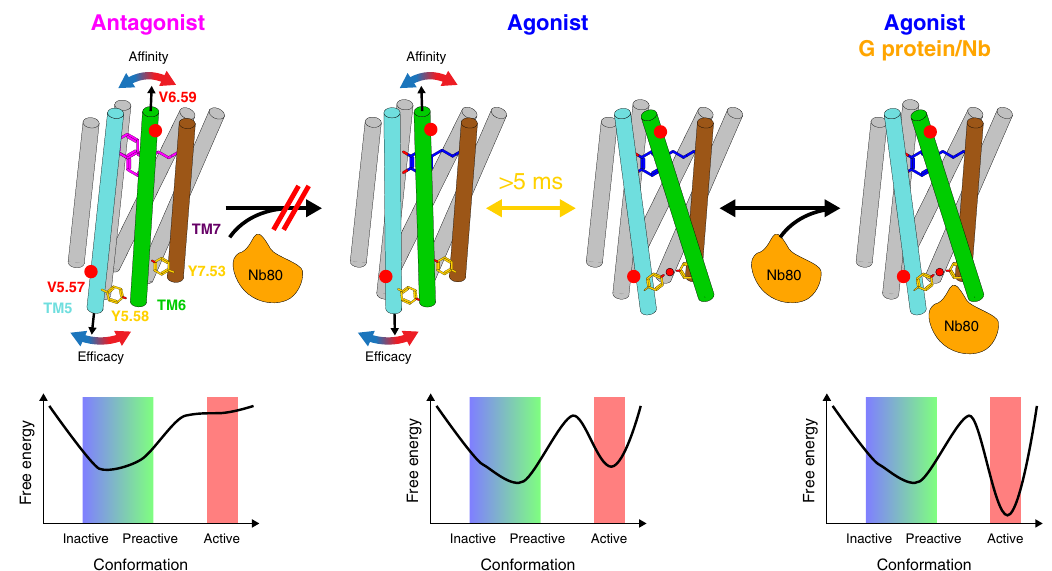
Fig. 8 Overview of observed β 1 AR conformational dynamics in response to ligands. Top: overview of conformational averages in various ligand-bound forms: (i) the antagonist complex in fast equilibrium biased to an inactive conformation, (ii) the agonist complex in fast equilibrium biased towards the preactive conformation and in a further slow equilibrium (closing of YY-bridge) with the active conformation, (iii) the ternary agonist (cid:129) effector protein complex in the fully active conformation. Arrows indicate readouts of conformational averages provided by chemical shifts that correlate to ligand ef fi cacy (V 5.57 ) and af fi nity (V 6.59 ). YY-bridge residues Y 5.58 and Y 7.53 are shown in yellow. Bottom: free energy landscape corresponding to the various ligand- bound